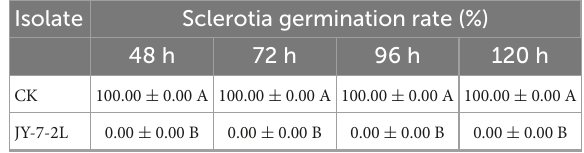
TABLE 3 Effect of JY-7-2L cell-free culture filtrate on sclerotia germination of Sclerotium rolfsii .